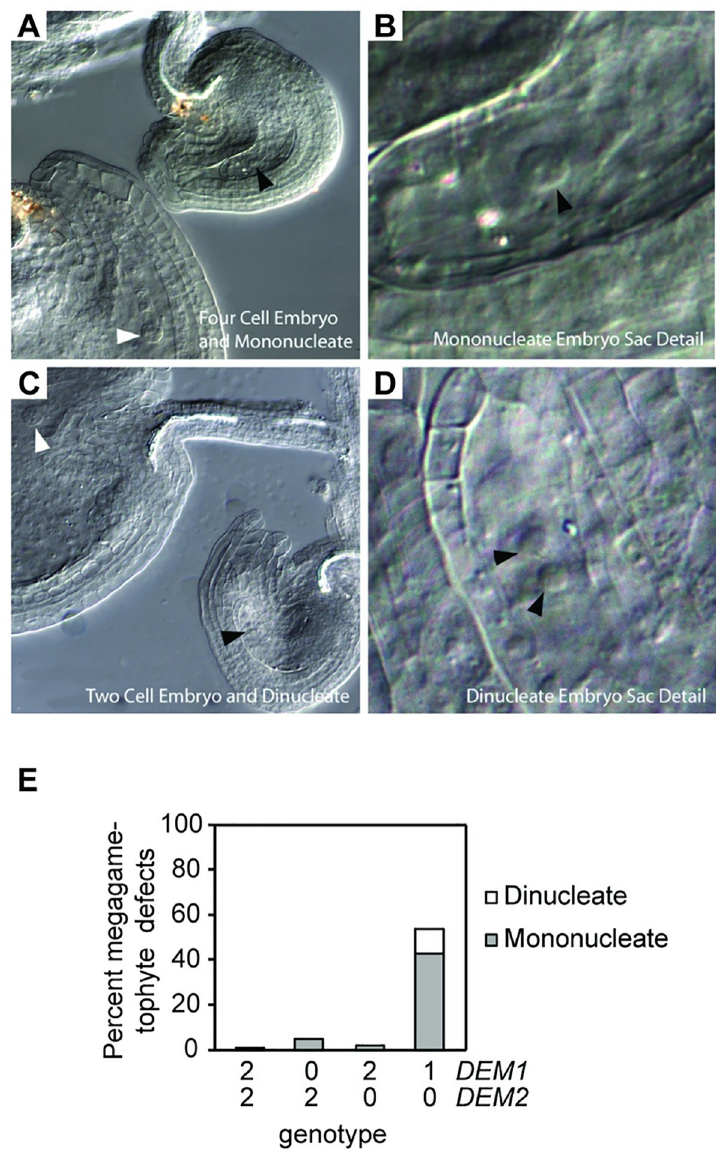
Fig 6. DEM1 and DEM2 are required for normal megagametophyte development in Arabidopsis . (A-D) Defective female gametophytes produced in DEM1/dem1 dem2/dem2 plants (Ws-0 genetic background). Developing ovules were observed as cleared whole mounts. (A-B) Four cell embryo (white arrowhead) and mononucleate embryo sac (black arrowhead) in two adjacent ovules. (C-D) Two cell embryo (white arrowhead) and di-nucleate embryo sac (black arrowheads) in two adjacent ovules. (E) Percentage of mononucleate and di-nucleate embryo sacs in self- fertilized wild-type and DEM1/dem1 dem2/dem2 plants of ecotype Ws-0. At least 200 ovules were assayed, involving at least three separate plants for each genotype. X-axis represents the copy number of DEM1 and DEM2 wild-type alleles in each genotype.